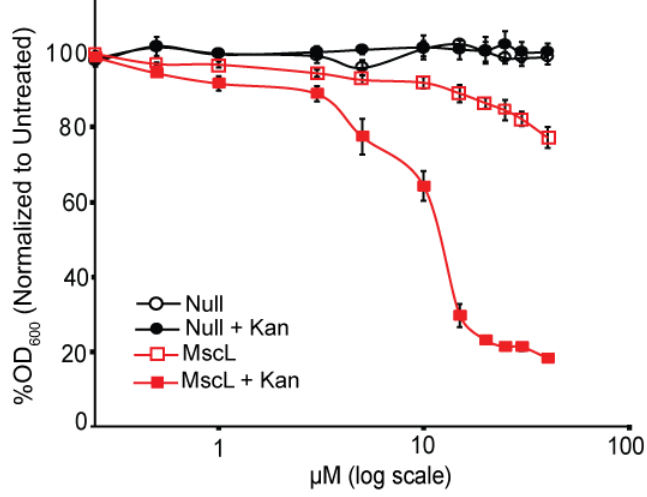
Figure 8. Compound 262 increases the potency of the common antibiotic kanamycin, only when MscL is present. Values are expressed as a percentage of growth (OD 600 ), relative to non-treated samples. MJF455 ( Δ MscL, Δ MscS) cultures carrying empty plasmid (Null) or expressing E. coli MscL (MscL) were treated with varying concentrations of compound 262 and grown in the presence or the absence of 0.5 µM kanamycin as indicated (n = 3–4). Error bars show the standard errors of the means (SEMs).